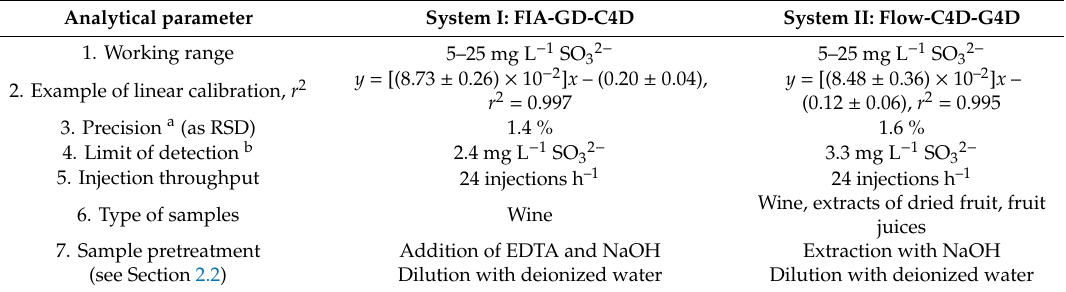
Table 2. Analytical performance of the flow systems with an in-line GD-C4D system for the determination of total